Question: In one sentence, what is this figure communicating?
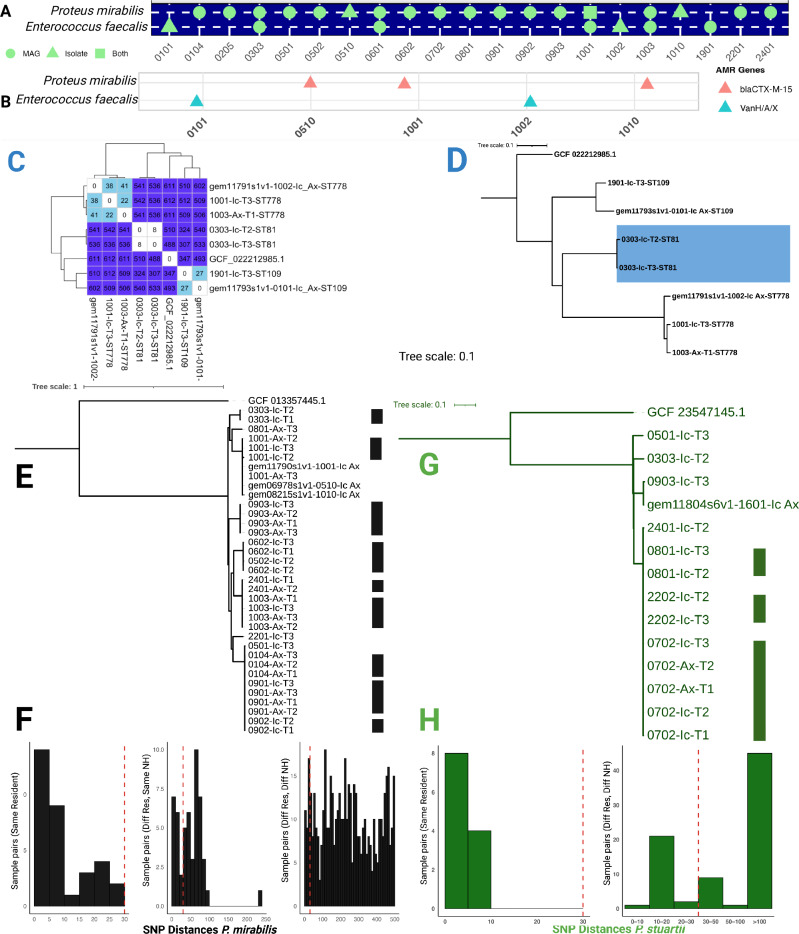
Answer: Genomic relatedness of healthcare-associated microbes colonizing nursing home residents. A Detection of Proteus mirabilis and Enterococcus faecalis on skin across NH residents, based on recovery as metagenome-assembled genome (MAG) from shotgun metagenomics, cultured isolate, or both. B Antimicrobial resistance gene detection in isolate genomes. bla CTX-M-15 was found in P. mirabilis isolates, while vanHAX operon genes ( vanH , vanA , vanX ) were identified in E. faecalis . Resident 0510 was not a participant in our skin microbiome sequencing cohort but resides in one of the NHs included in this study. C Pairwise SNP distance heatmap among E. faecalis strains. Lower values indicate greater genomic similarity. Samples starting with the identifier “gem” are isolate genomes. MAGs are labeled with ResidentID-bodysite-timepoint-ST. Light blue shading is 10-100 SNPs; Blue shading is 100–1000 SNPs. D Maximum likelihood phylogeny of E. faecalis isolates and MAGs, displaying clustering by resident and timepoint; the blue shade marks E. faecalis from the same resident. E Phylogenetic tree of P. mirabilis strains shows resident-specific clustering, highlighted with black side bars. F Histograms for P. mirabilis of SNP distances of genomes from the same resident, genomes of different residents within the same NH and genomes from residents of different nursing homes. G Phylogenetic tree of Providencia stuartii MAGs shows resident-specific clustering, highlighted with green side bars. H Histograms for P. stuartii comparing SNP distances of genomes from the same resident with between residents. Red dashed lines indicate the 30 SNP threshold for defining closely related strains. Figure panels were assembled using Biorender under publication license, Segre, J. (2026) https://BioRender.com/8nr8pf3 .